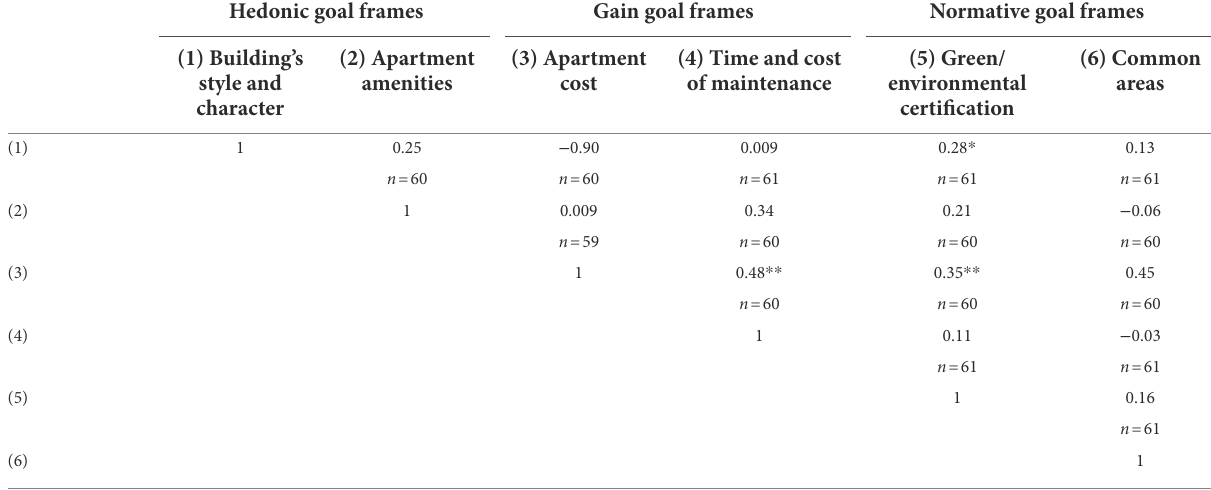
TABLE 2 Relationships between the six building aspects and the three goal